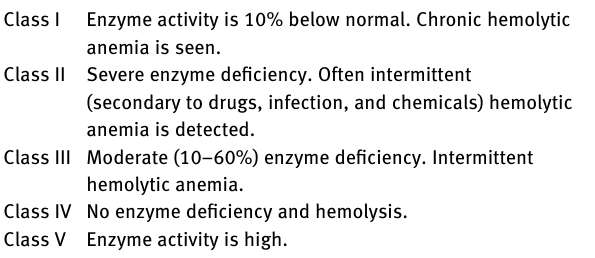
Table  : WHO G  PD de fi ciency classi fi